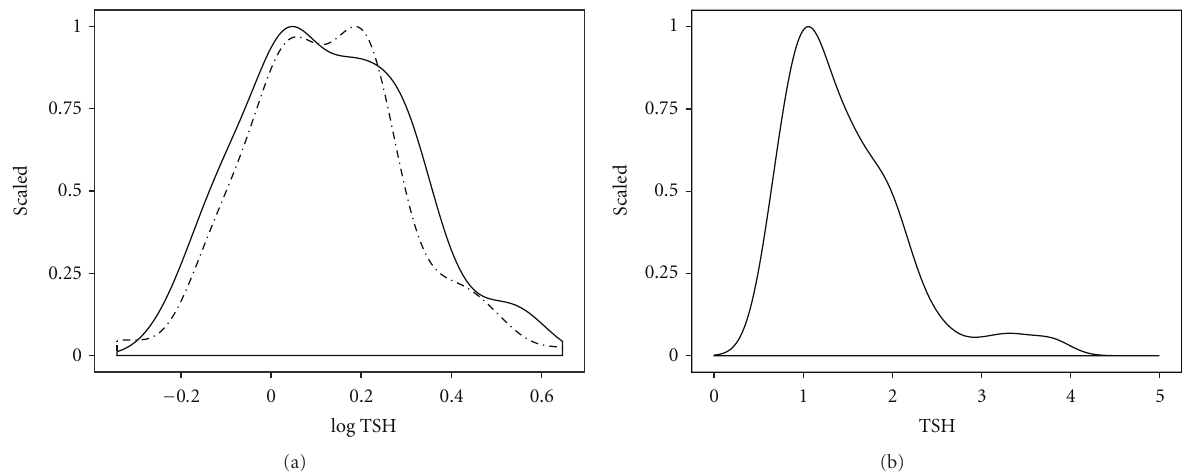
Figure 1: Distribution of logTSH (a) and TSH (b) in a clinical sample, compared to a random distribution. The distribution (solid line) was obtained from TSH measurements in 150 euthyroid subjects; a random distribution ((a), broken line) artificially generated by taking the mean and standard deviation of the sample.